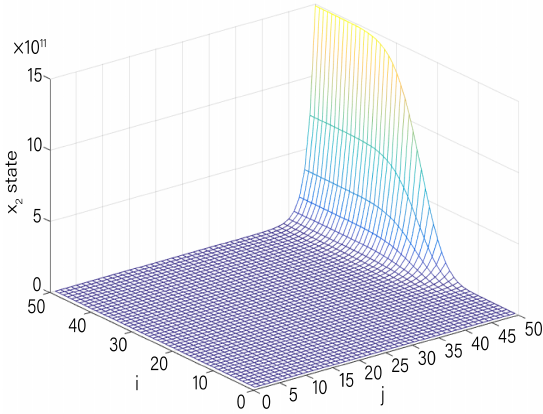
Figure 3. Open-loop state space response of x 2 ( i , j ) .